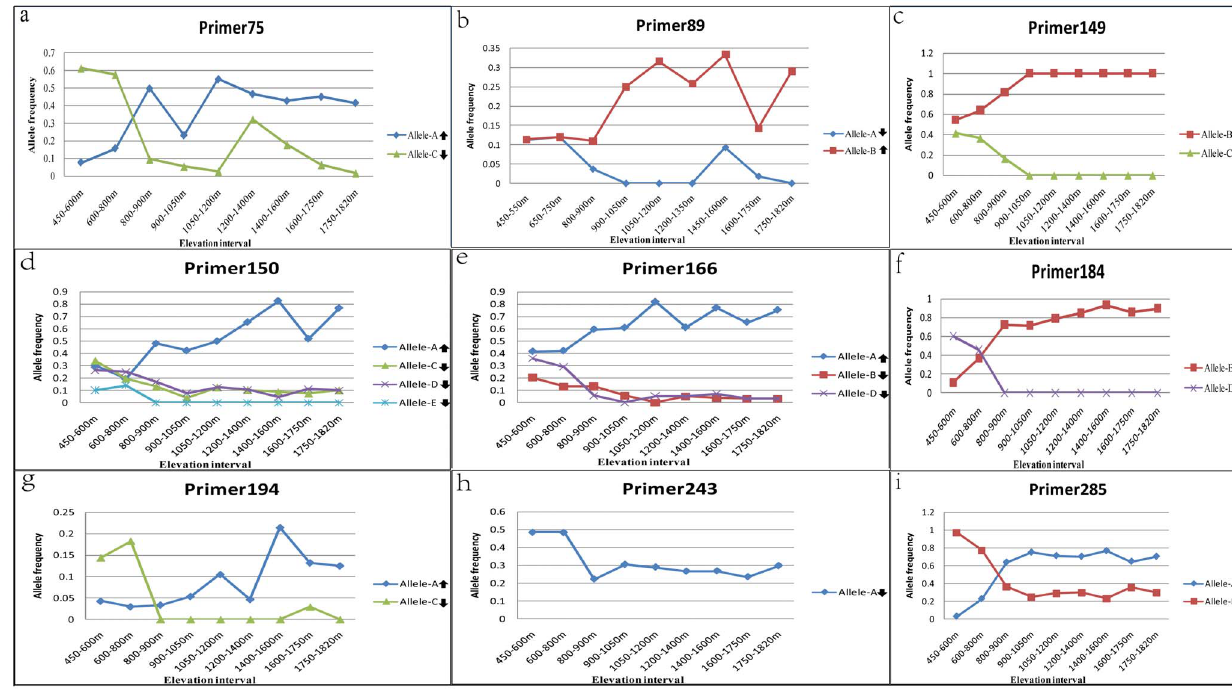
Figure 3. Variation in allele frequencies among different elevation intervals. ( a–i ) Genetic loci of different primer pairs. Alleles labeled with a down-arrow are type-II alleles, whose frequencies were negatively correlated with increasing elevation; alleles labeled with an up-arrow represent type-III alleles, whose frequencies were positively correlated with increasing elevation. The elevation range was divided as described in Fig. 2. Only type-II and type-III alleles generated by different primers are displayed; type-I alleles, whose frequencies were uncorrelated with elevation, are not shown.